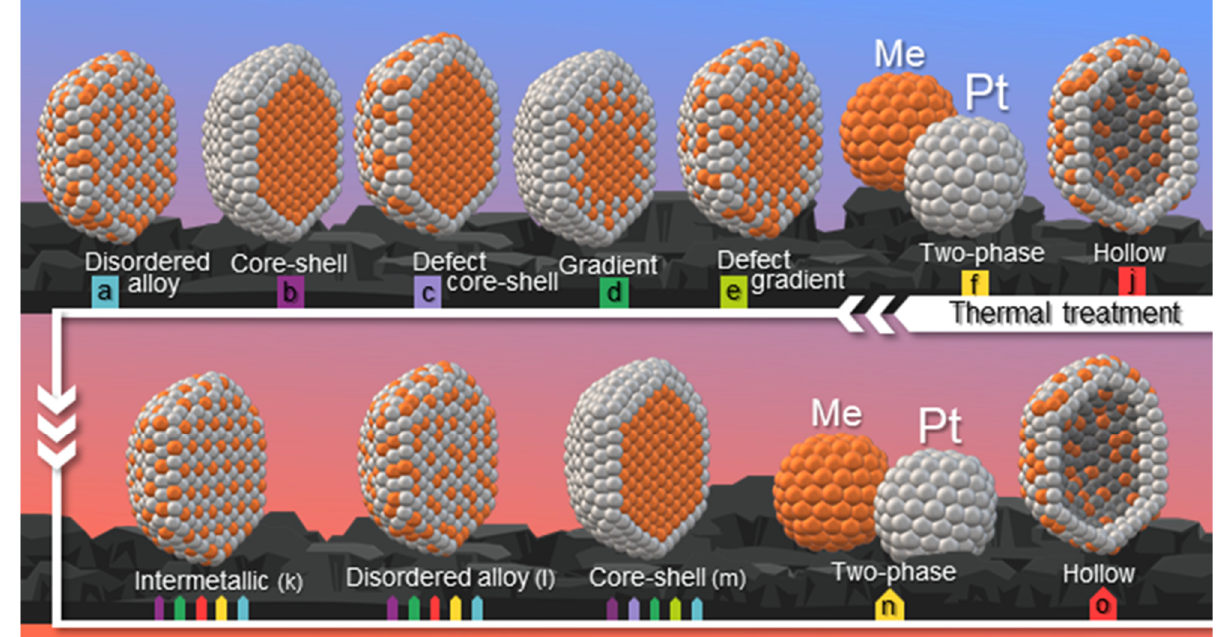
Figure 5. Scheme of possible transitions in the structures of bimetallic NPs under the heat treatment: ( a , l ) disorder alloy, ( b , m ) core-shell, ( c ) defect core-shell, ( d ) gradient, ( e )defect gradient, ( f , n ) two- phase, ( j , o ) hollow, ( k ) intermetallic. Platinum atoms are marked in gray; atoms of the alloying component are marked in orange. The top row represents examples of bimetallic nanoparticles structures in the “as-prepared” state. The bottom row represents the bimetallic particles structures after heat treatment. The background color of the letters corresponds to the same structure before and after processing.